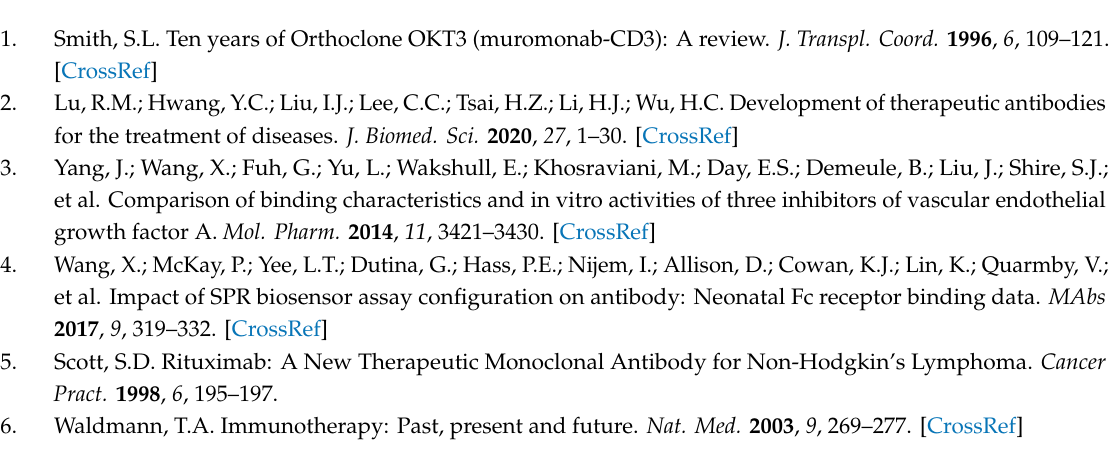
Figure S1: Ratio of Rmax (E) and Rmax (T) of recombinant MSLN ECD expressed by ( A ) E.coli; and ( B ) CHO cells (fractions with the least glycosylation). Rat MSLN ECD expressed by CHO cells was not tested due to unavailability of the protein. Rmax (E) and Rmax (T) are maximum binding responses determined experimentally and theoretically, Figure S2: Surface stability test of anti-FD Fab. Level of anti-FD Fab captured by an anti-Fab antibody over 15 minutes in an indirect capturing format at 37 ◦ C. Level of anti-Fab antibody immobilized was approximately 8000 RU, and anti-FD Fab was indirectly captured at approximately 80